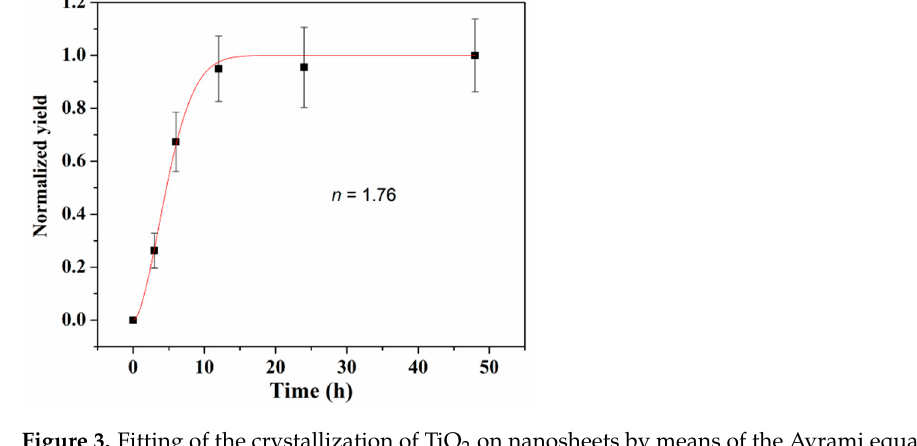
Figure 3. Fitting of the crystallization of TiO 2 on nanosheets by means of the Avrami equation (red line is the fitting curve).